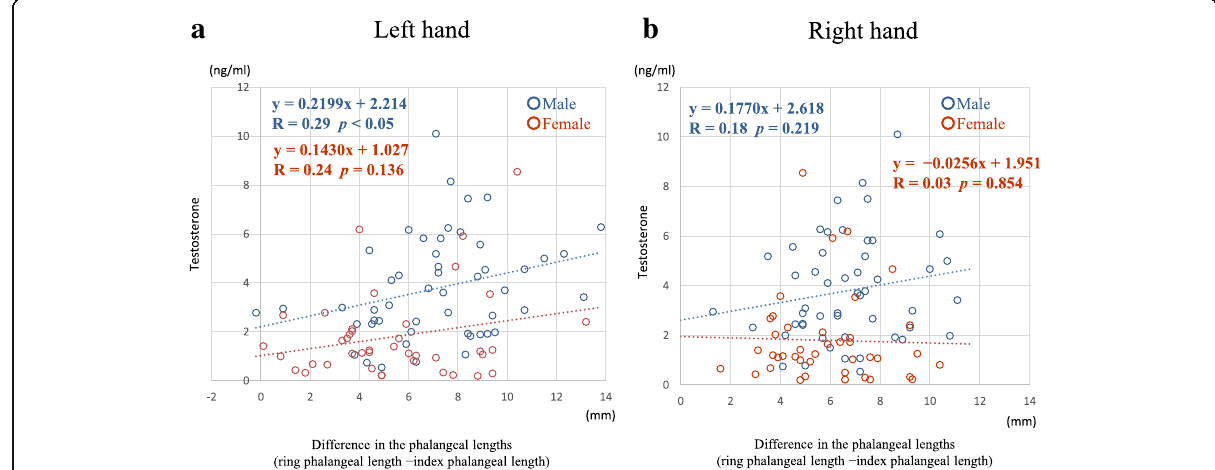
Fig. 5 Correlations between testosterone levels in the right heart serum and the difference in ring and index phalangeal lengths in ( a ) the left hand and ( b ) the right